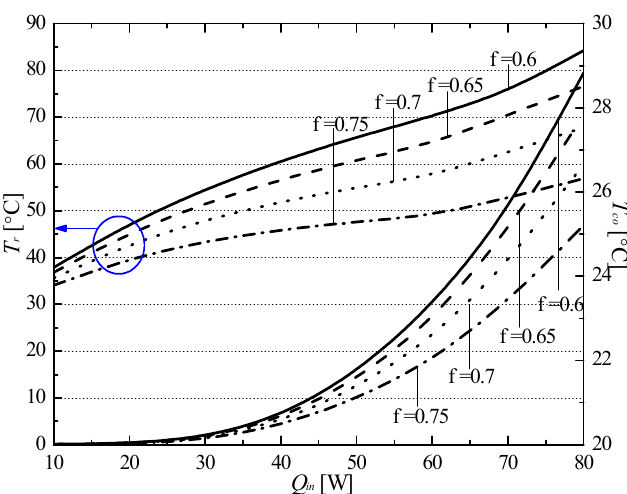
Figure 11. Variations in T r and T co with input thermal load for different porosities.